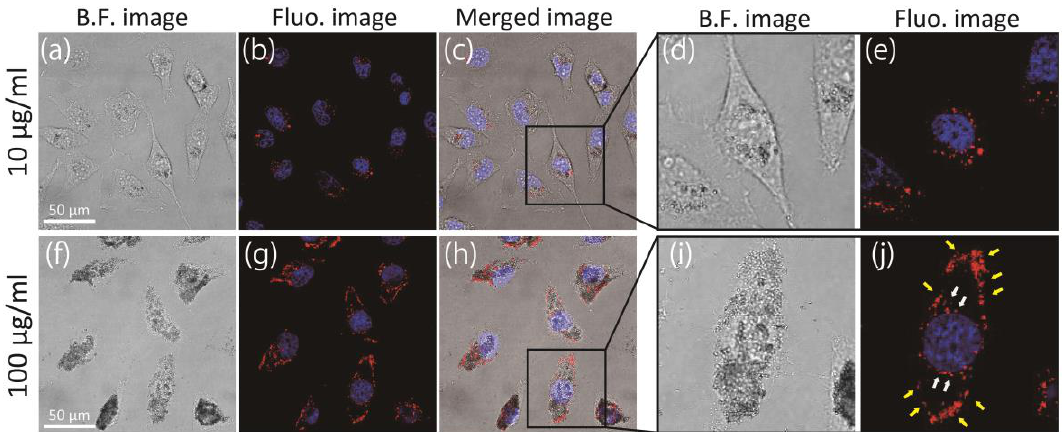
Figure 4. ( a – j ) Bright-field, confocal fluorescence (FNDs in red and nuclei in blue) on the level of cell nuclei, and merged images of HeLa cells treated with FND-HPGTMA at 10 µ g/mL ( a – e ) and 100 µ g/mL ( f – j ). Close-up images of black square areas in (c,h) are also shown (d,e,i,j). White and yellow arrows in (j) indicate internalized and membrane-anchored FNDs, respectively.